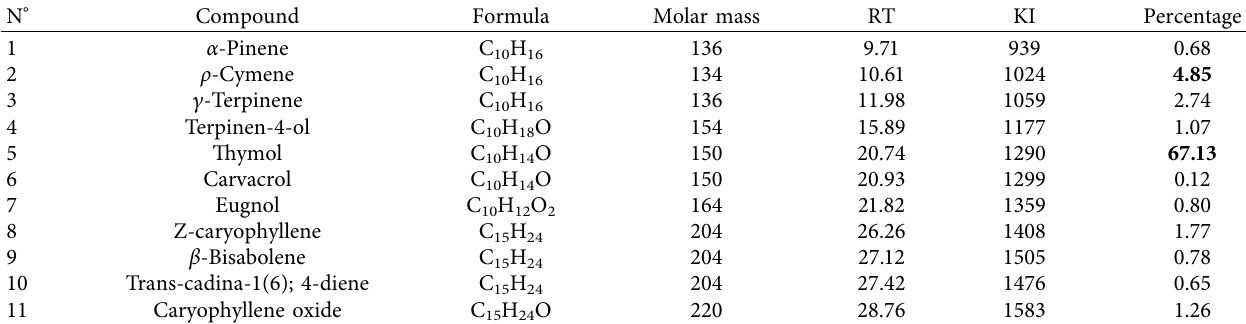
Table 1: Chemical composition of commercial thyme EO.